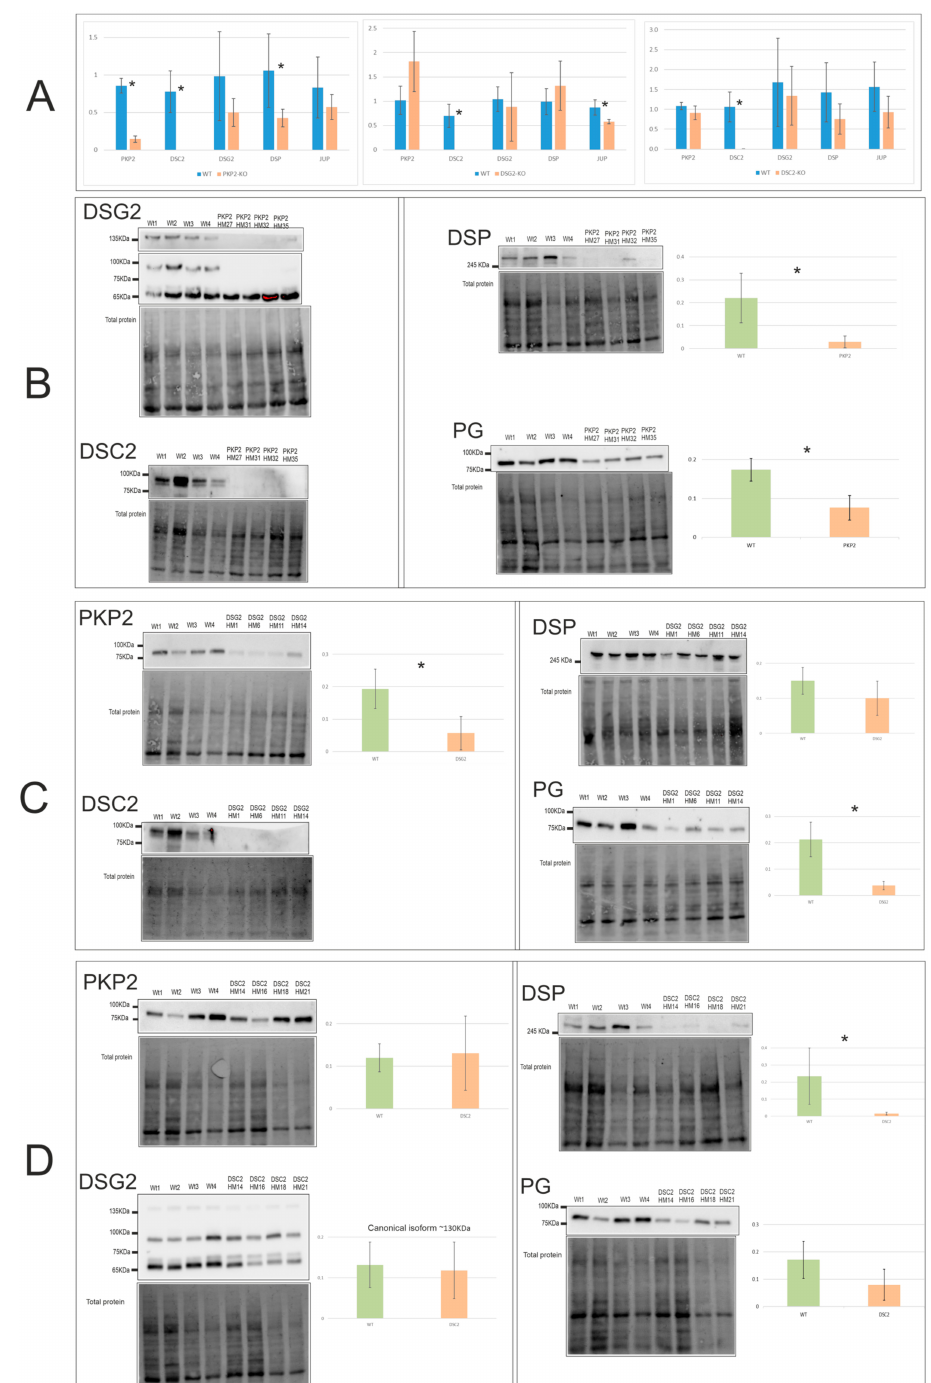
Figure 1. Desmosomal expression levels of mRNA ( A ) and protein of the edited clones PKP2 -KO ( B ), DSG2 -KO ( C ), and DSC2 -KO ( D ). * Indicates the gene expression levels that were significantly different between WT and edited clones; p -value < 0.05, see Table S4. Number of experiments: RT-PCR = 1; WB =